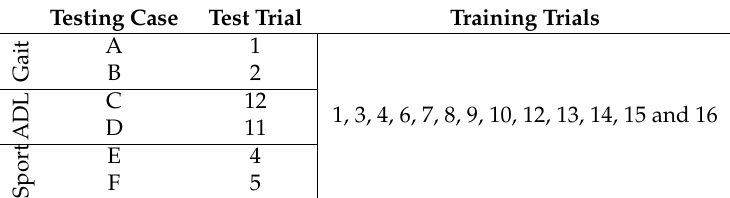
Table 3. Description of the six testing cases, for the specified training